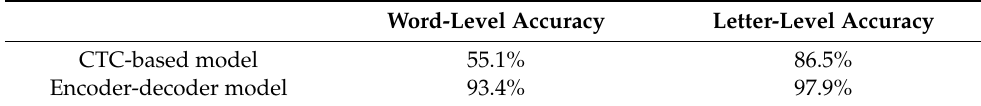
Table 5. User-independent validation of sequence recognition models.